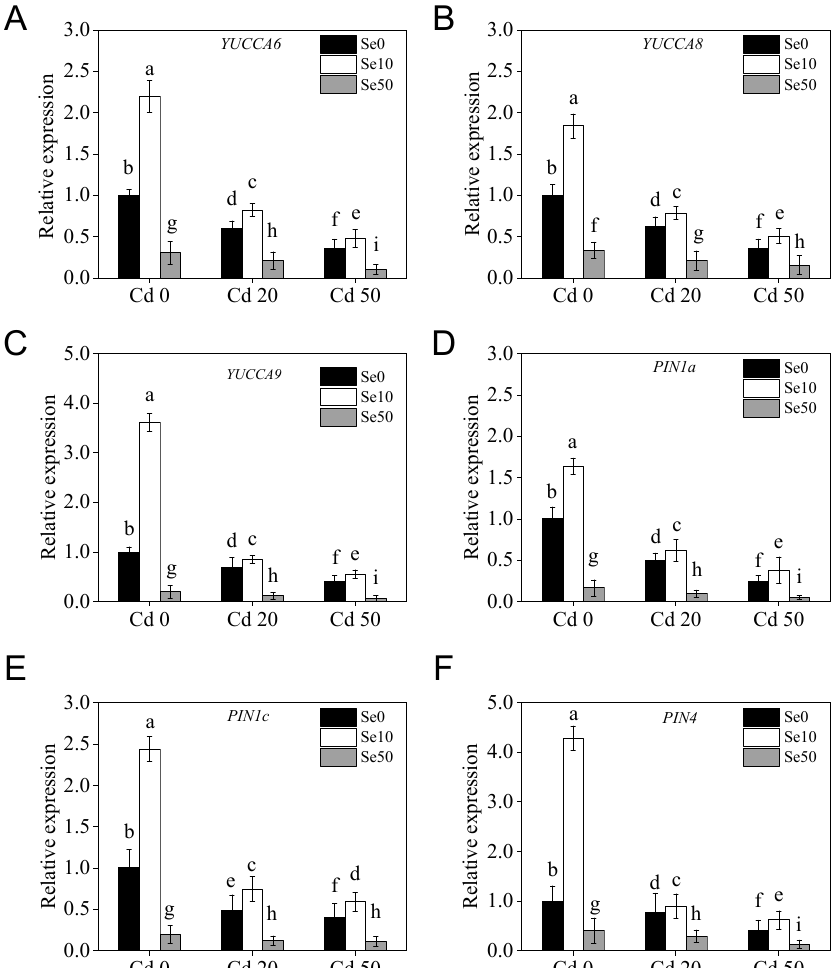
Figure 5. Expression of auxin-relative gene in tobacco under different Se and Cd concentration supply conditions. ( A –C) Expression of three members ( YUCCA6, 8, 9 ) of the tobacco YUCCAs family genes in shoots under different Se and Cd concentration supply conditions.; ( D – F ) Expression of three members ( PIN1a, 1c, 4 ) of the tobacco PINs family genes in roots under different Se and Cd concentration supply conditions. 14-days-old seedlings ( DR5::GUS transgenic tobacco) were grown in pot with sand under different Se (0, 10, 50 μ M) and Cd (0, 20, 50 μ M) concentrations for 21 days. The tobacco housekeeping gene L25 was used as an internal control. The relative expression levels are shown compared with the expression under Cd0 and Se0 (Cd0 + Se0) conditions as 1 expression. Se0 : no Se; Se10 : Se, 10 μ M; Se50 : Se, 50 μ M; Cd0 : no Cd; Cd20 : Cd, 20 μ M; Cd50 : Cd, 50 μ M. Shown are mean ± SD from five biological replicates. Different letters indicate significant differences ( p < 0.05).